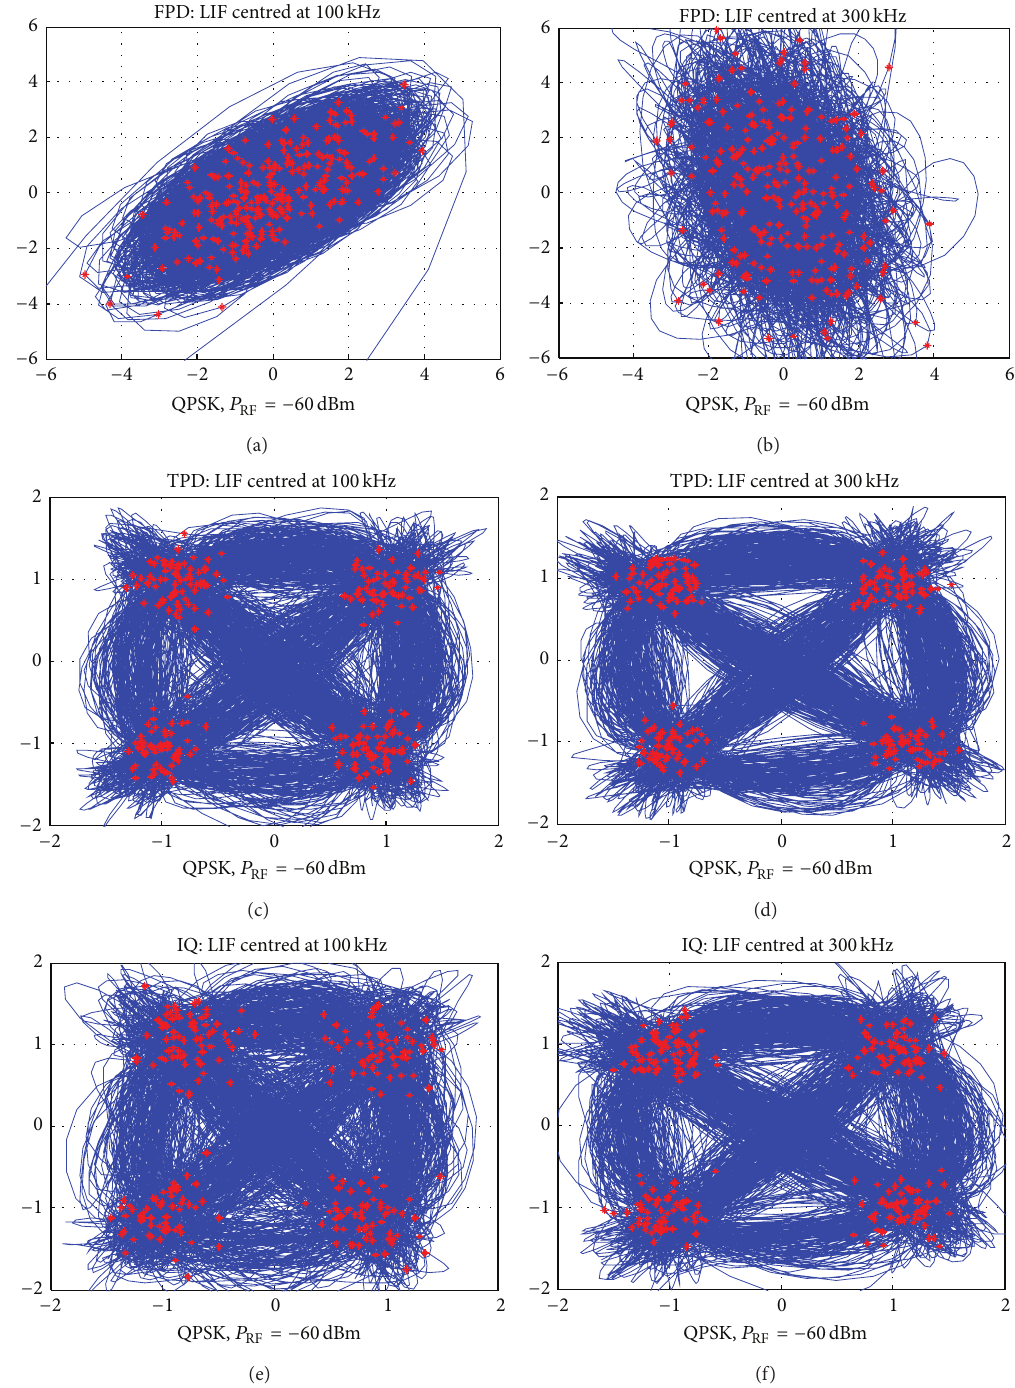
Figure 11: Constellation diagrams corresponding to the demodulation of of two −60 dBm QPSK modulated carriers @2.4 GHz and 2.8 GHz for FPD, TPD, and